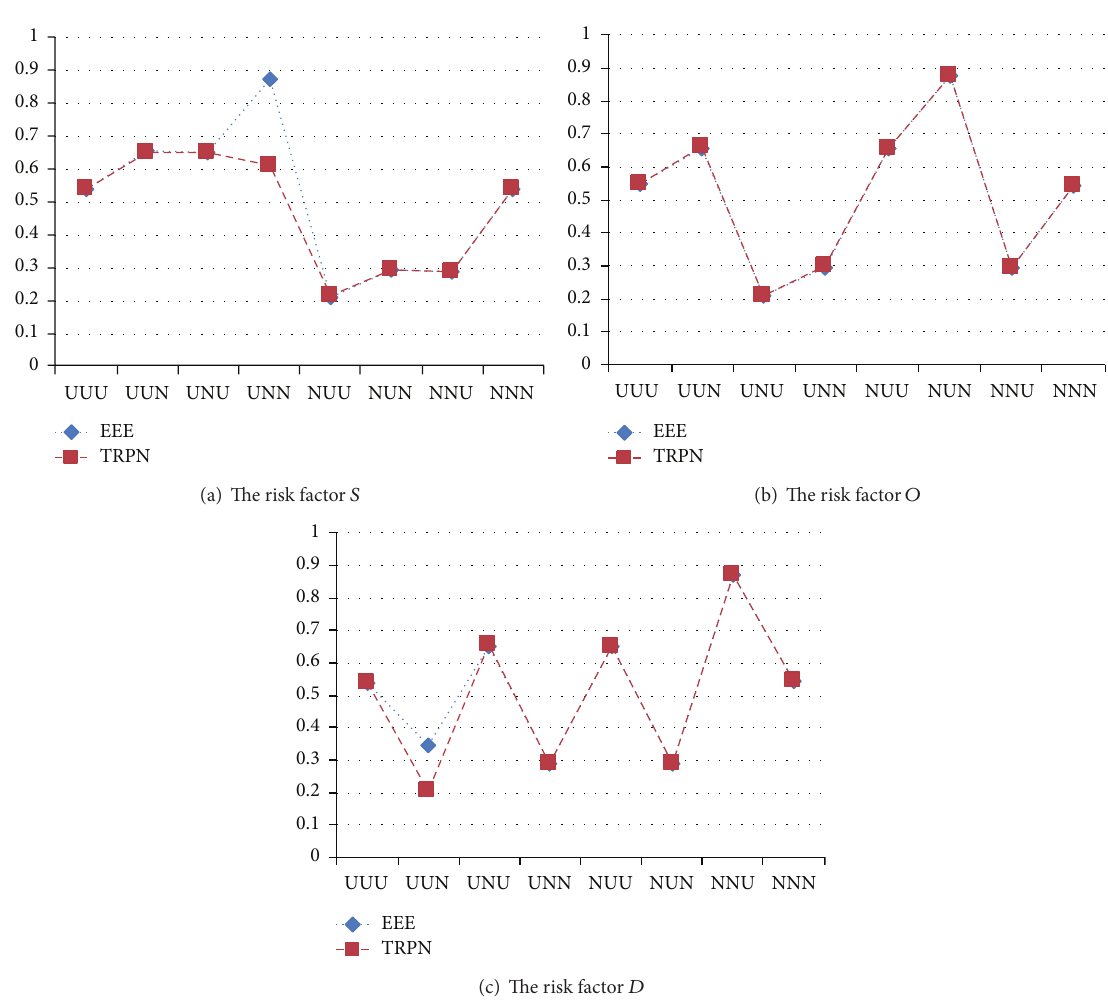
Figure 3: Distribution sketch with respect to risk factors and risk weights.